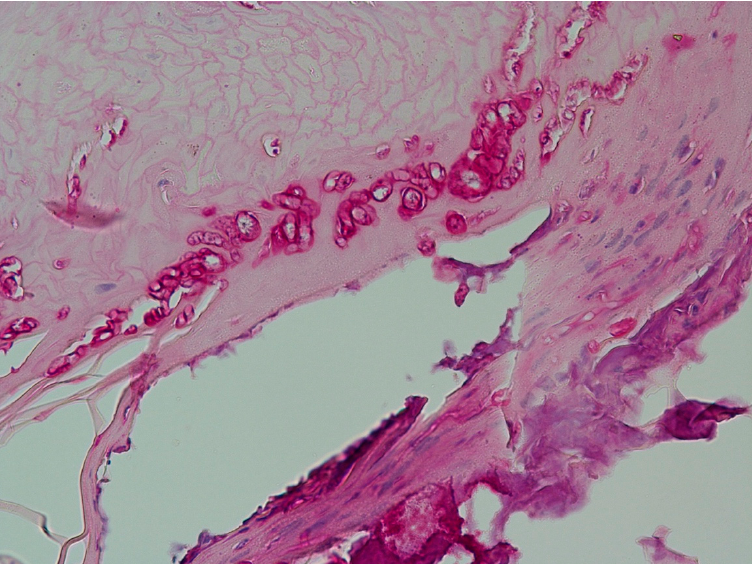
Figure 4. Histopathology of a nail clipping from the index finger of a 39-year-old female patient showing long slender filaments suggestive of dermatophyte hyphae. PAS stain, original magnifica- tion 400×.